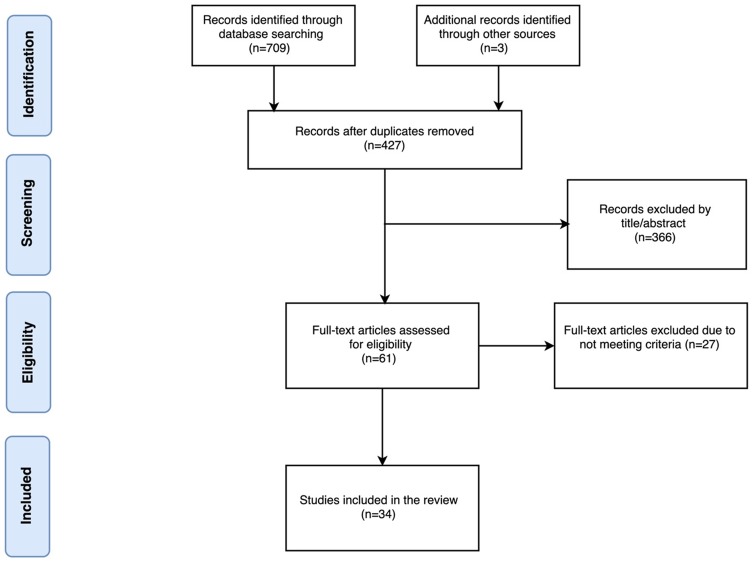
Study search and selection for measures of cardiovascular activity in insomniacs and controls.Modified PRISMA 2009 flow diagram [89].